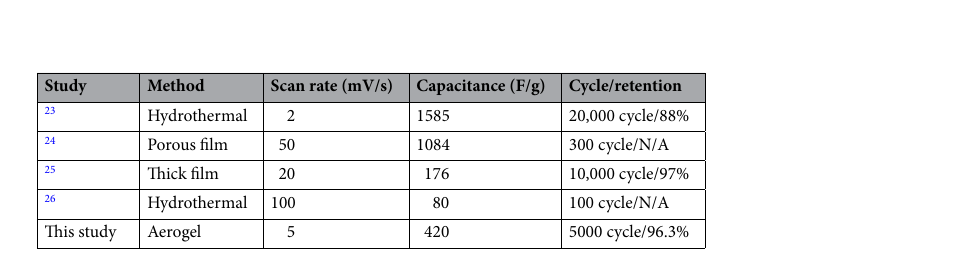
Table 3. Comparison of the Study with the